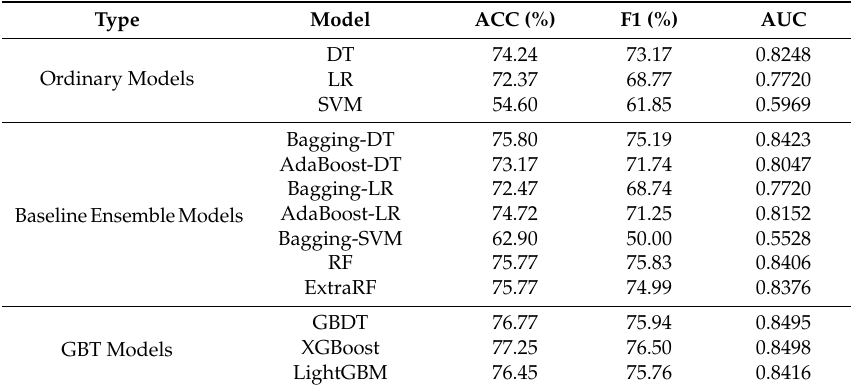
Table 4. Model comparison results on headset